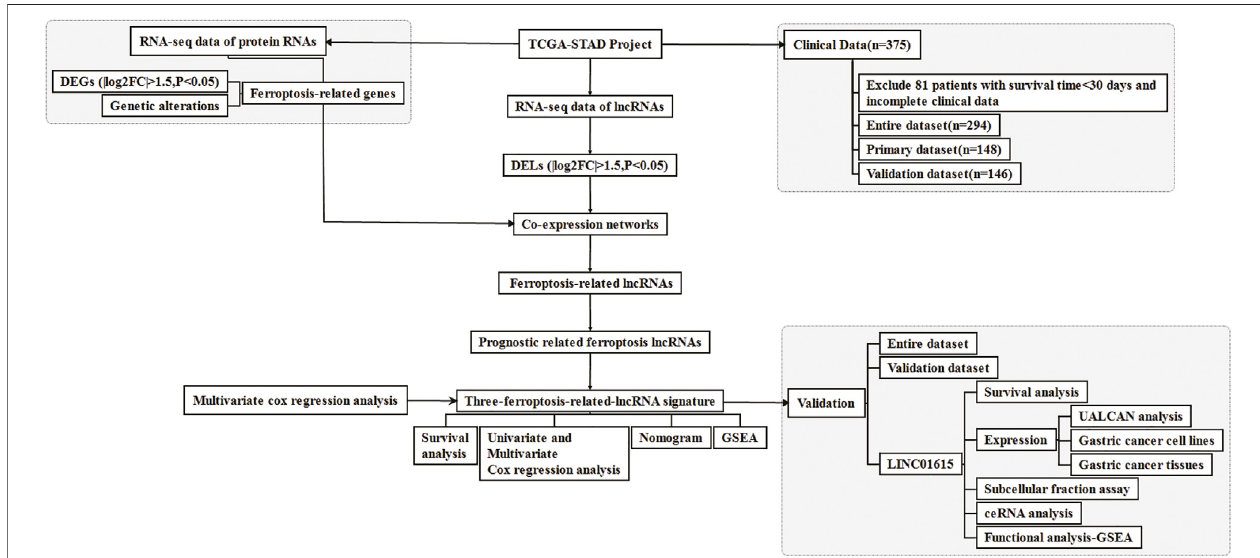
FIGURE 1 | Flow chart for the